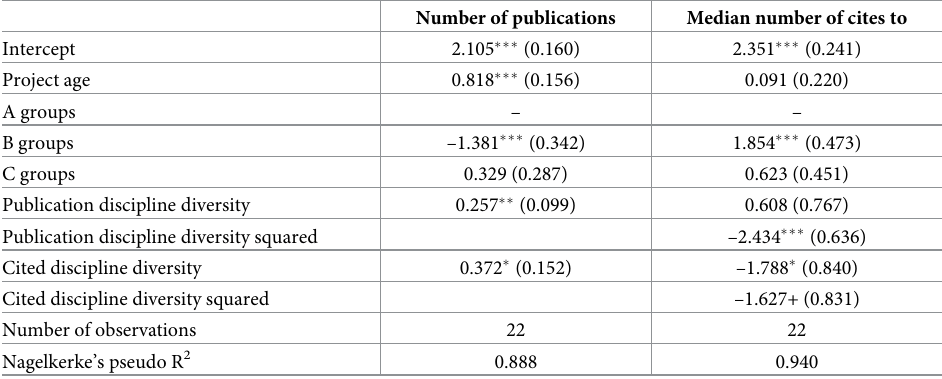
Table 3. Factors predicting output variables.